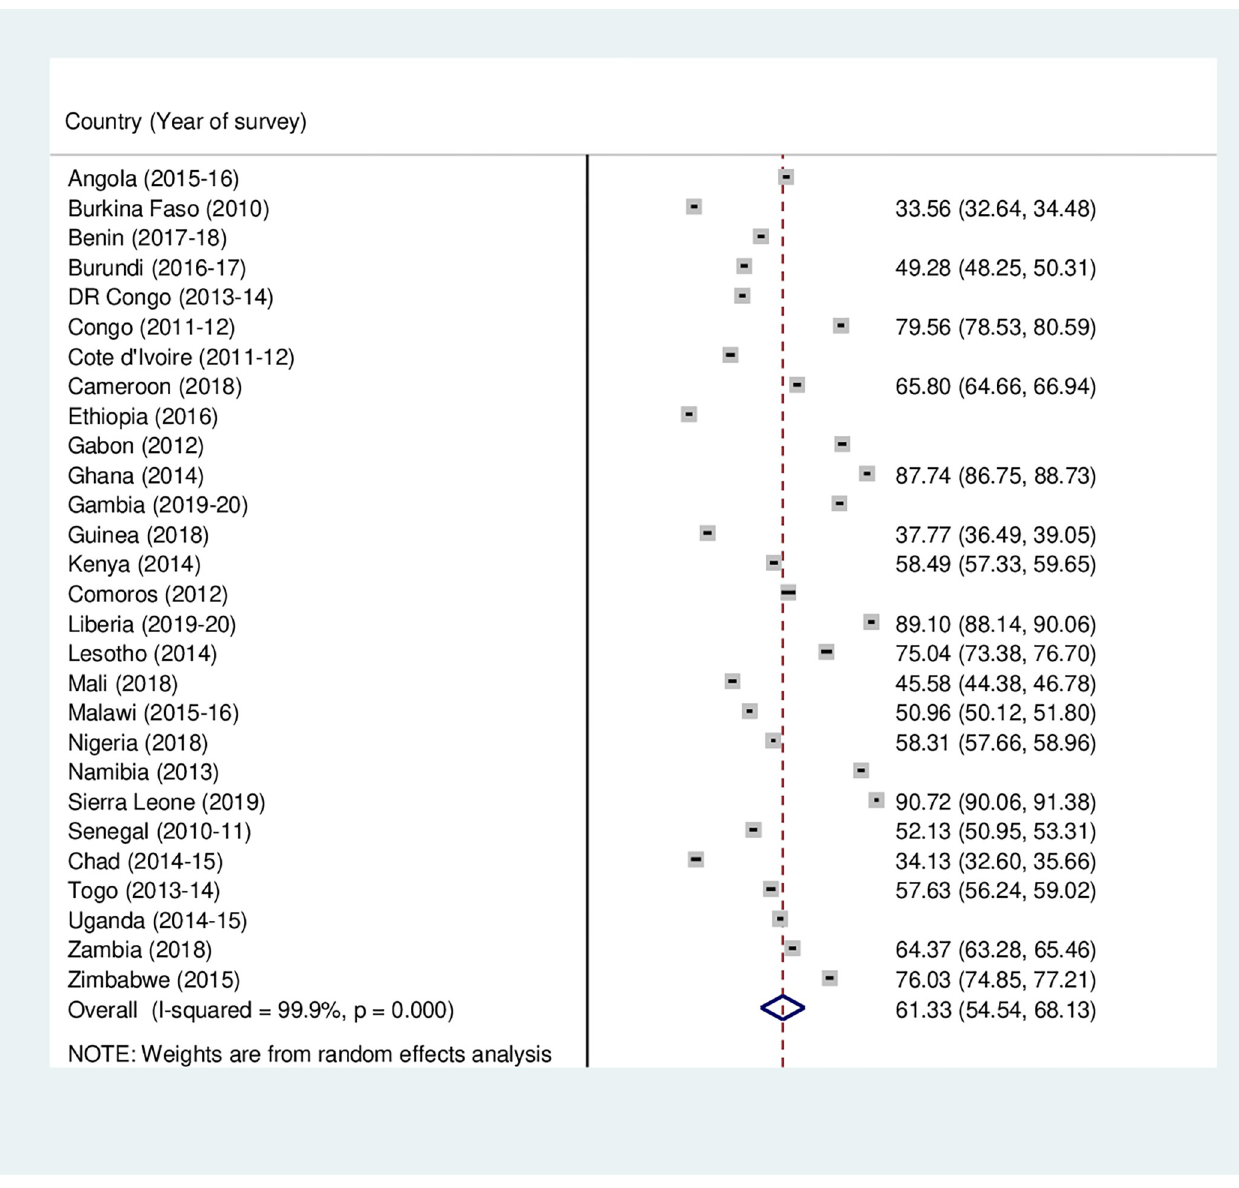
mation criterion (AIC). We selected the set of variables with the lowest AIC for this study. To